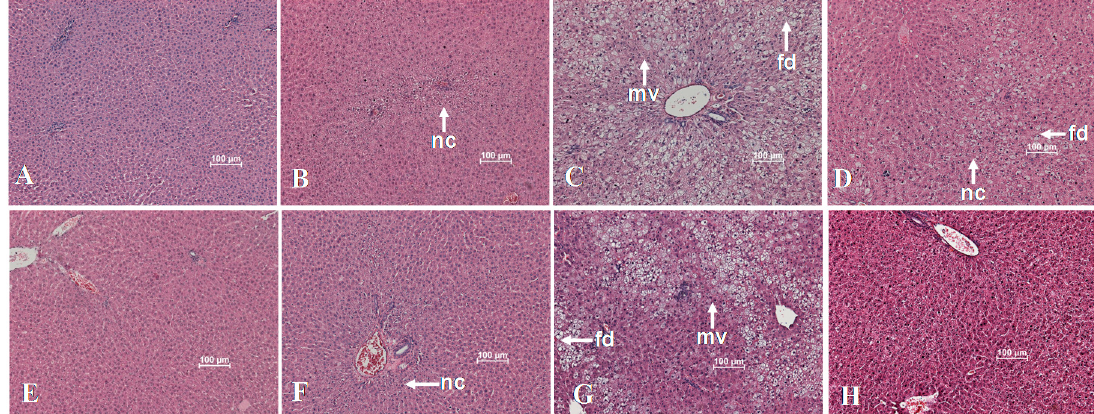
Figure 5. Effect of dietary treatment with raw or 4 day-germinated V. radiata and AIT protocol on liver histology (hematoxylin-eosin stain) of lean and obese Zucker rats. ( A ) RVR-LS, ( B ) RVR-LE, ( C ) RVR-OS, ( D ) RVR-OE, ( E ) GVR-LS, ( F ) GVR-LE, ( G ) GVR-OS, ( H ) GVR-OE. RVR, raw V. radiata , GVR, 4 day-germinated V. radiata . Groups: LS, Lean ( fa /+) sedentary rats, LE, Lean ( fa /+) rats